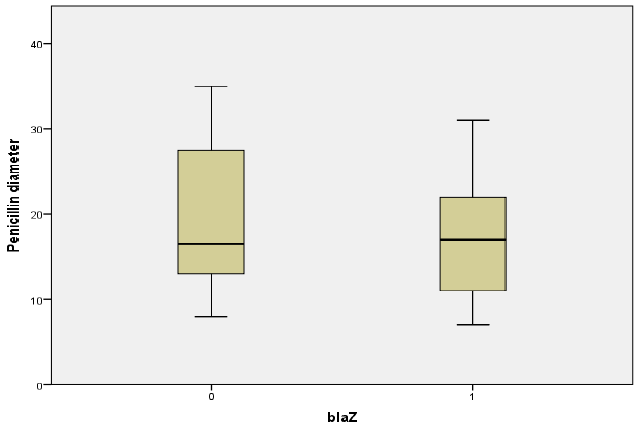
Figure 4. A Boxplot of penicillin diameter and blaZ gene (0 = blaZ -negative, 1 = blaZ -positive).